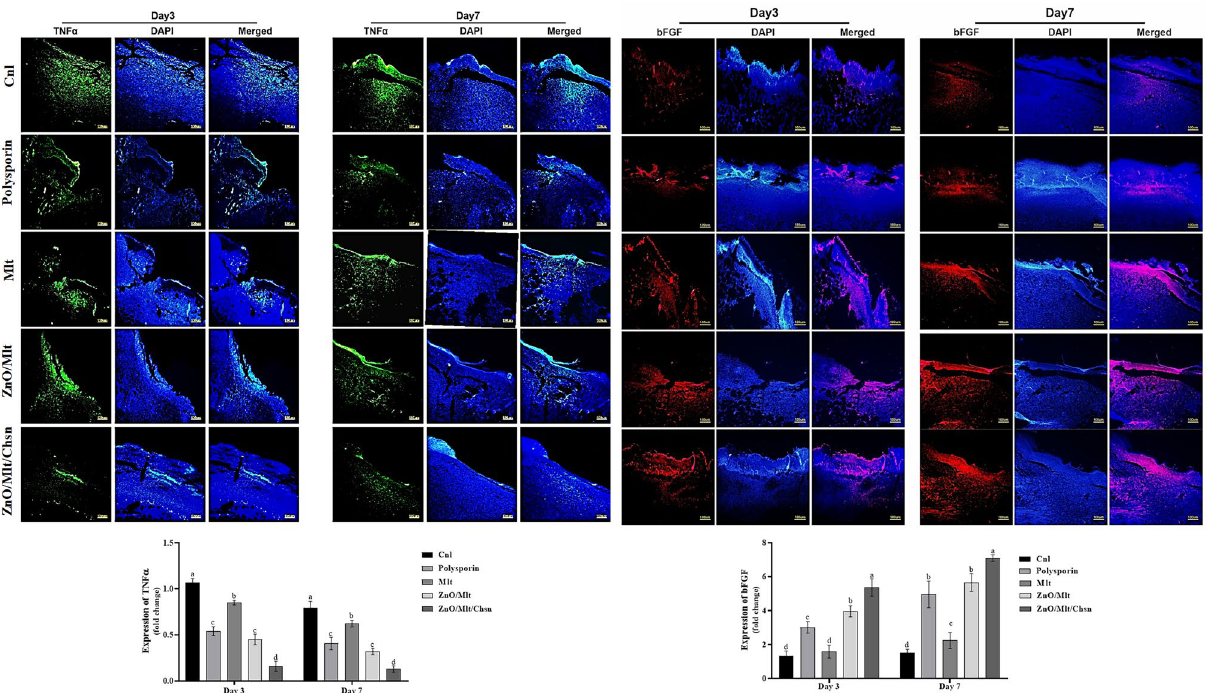
Figure 12. Cross-sectioning results of the protein expression of TNF-α and bFGF via the immunofluorescence staining on days 3 and 7 after wounding. See the TNF-α expression, which was significantly decreased, and the bFGF expression was significantly increased in the treated groups versus the control group. The different letters above each column indicate a difference in level ( P < 0.05 ) per sampling day.